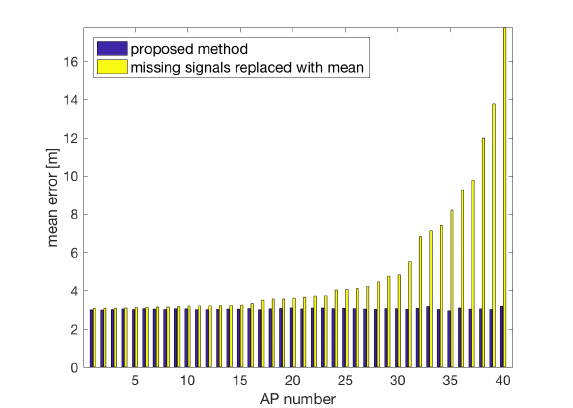
Figure 18. Comparison of the proposed system with replacement of missing signals with means calculated for the missing